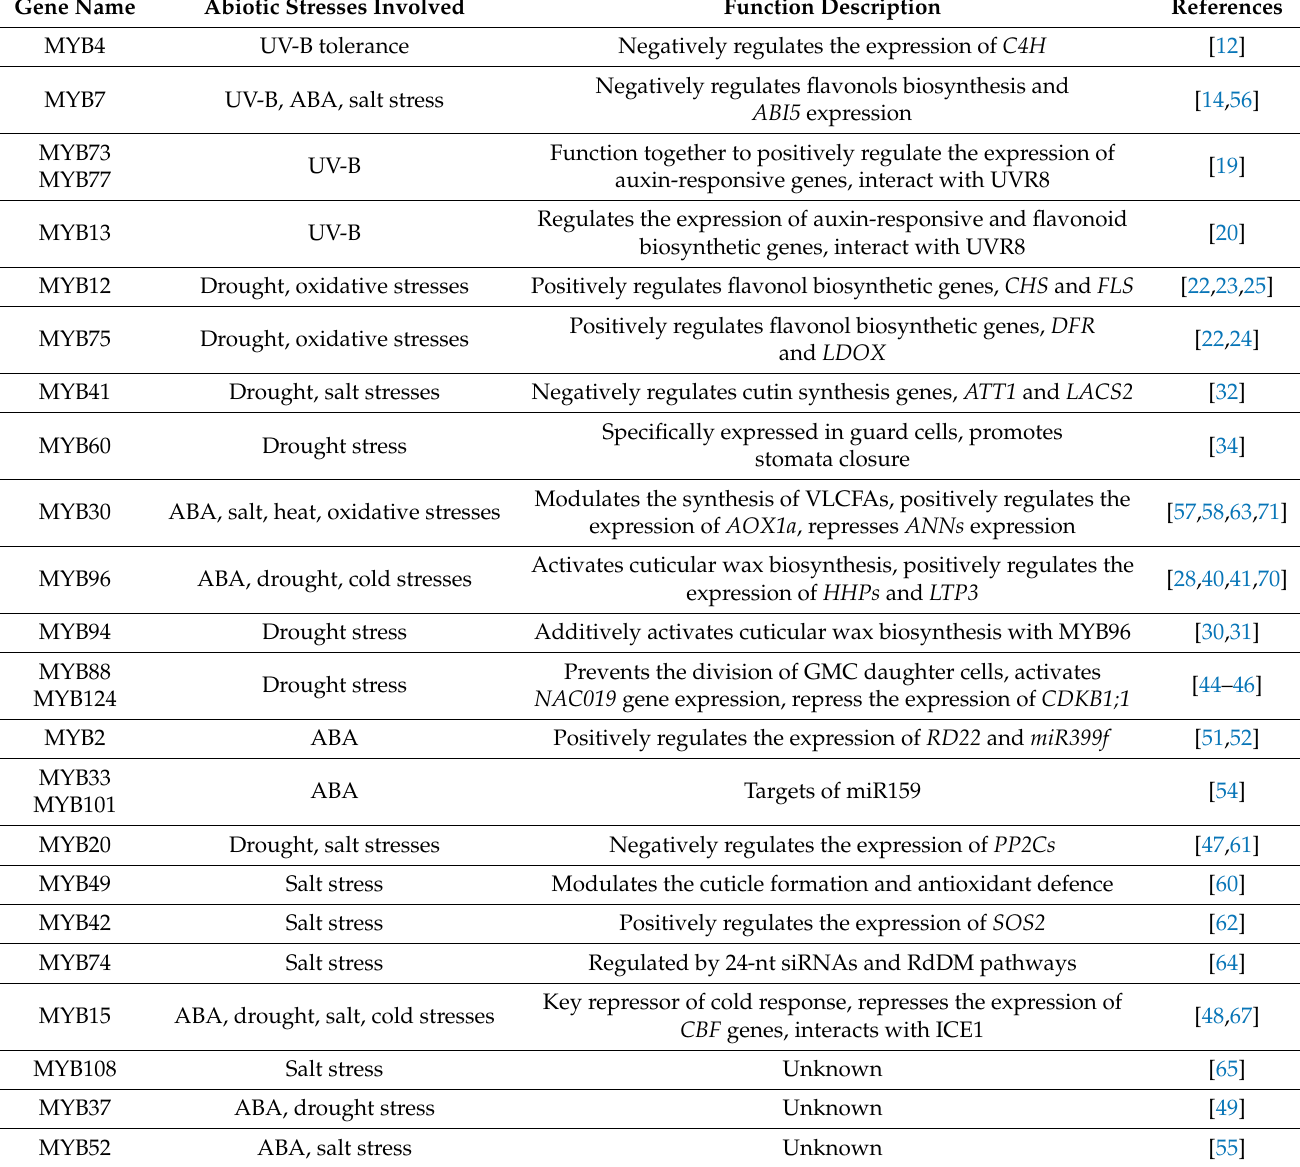
Table 1. MYB genes involved in abiotic stress